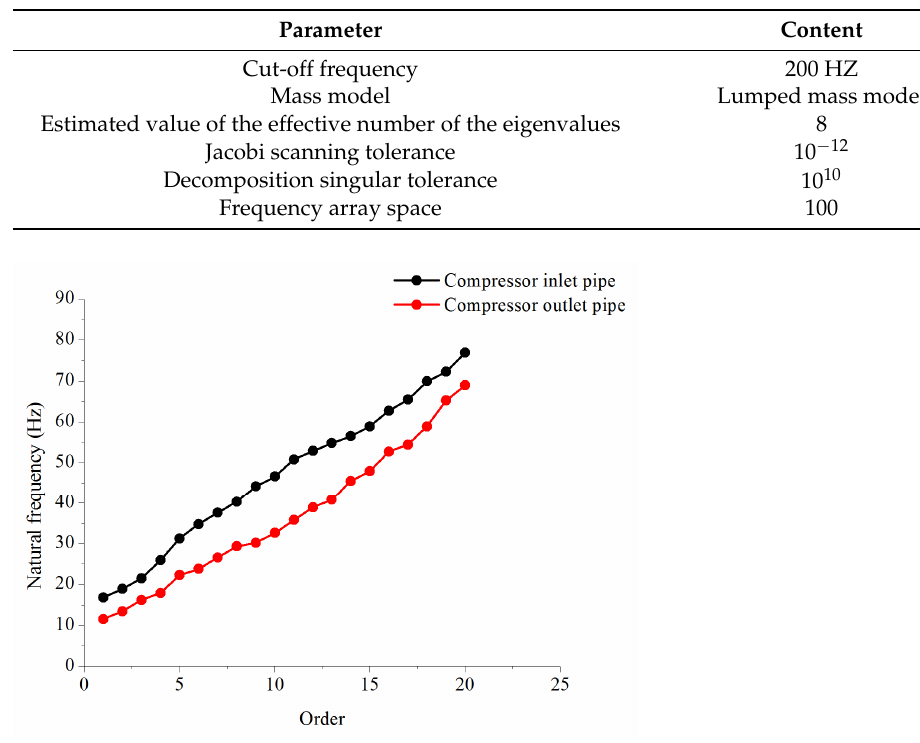
Table 5. Parameters of modal analysis.